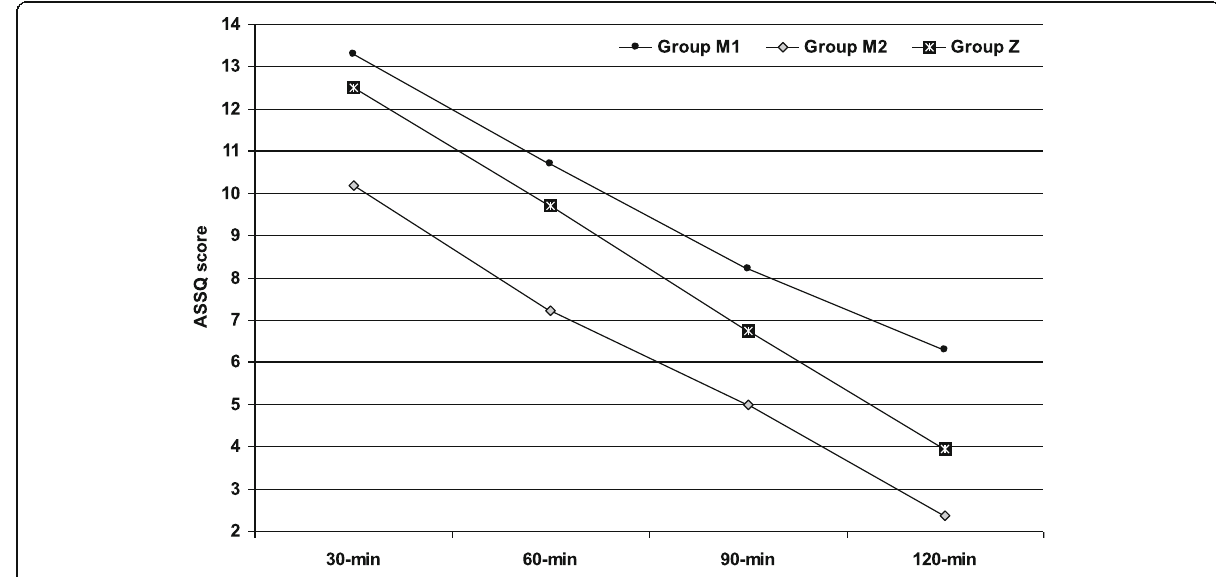
Fig. 3 Mean Anxiety Specific to Surgery Questionnaire (ASSQ) score of patients who received premedication treatment till 120 min